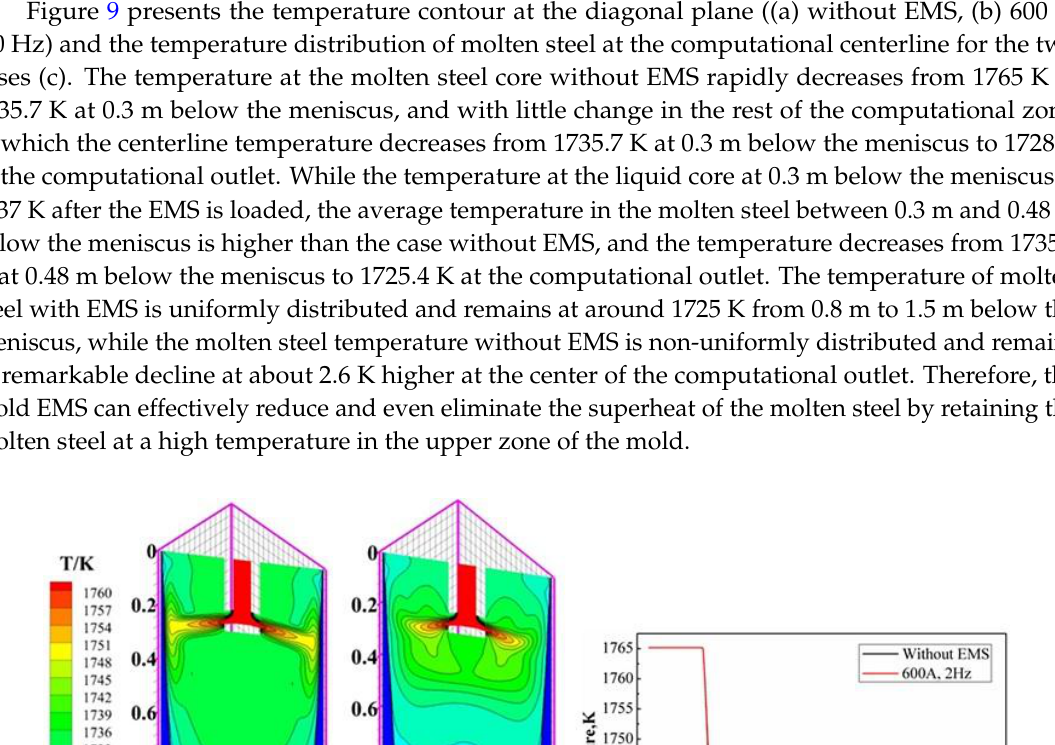
Figure 10. Temperature variations at the centerline of the bloom wide face and chamfered corner. Figure 11 shows the liquid fraction distributions at the diagonal plane and cross section of the EMS center ( z = 0.42 m) for the two different cases. The growth velocity of the solidifying shell at the mold corner in the impact area in the case without EMS is lower than the other because of a remarkable impingement of the jet flow on the corner wall, and the solidified shell thickness at the corner of the computational outlet is apparently thinner. Compared with the case without EMS, the solidified shell in the cross section z = 0.42 m in the case loaded with EMS is thicker at the corner, but thinner at both the wide and narrow sides, and the solidified shell distribution is more uniform.